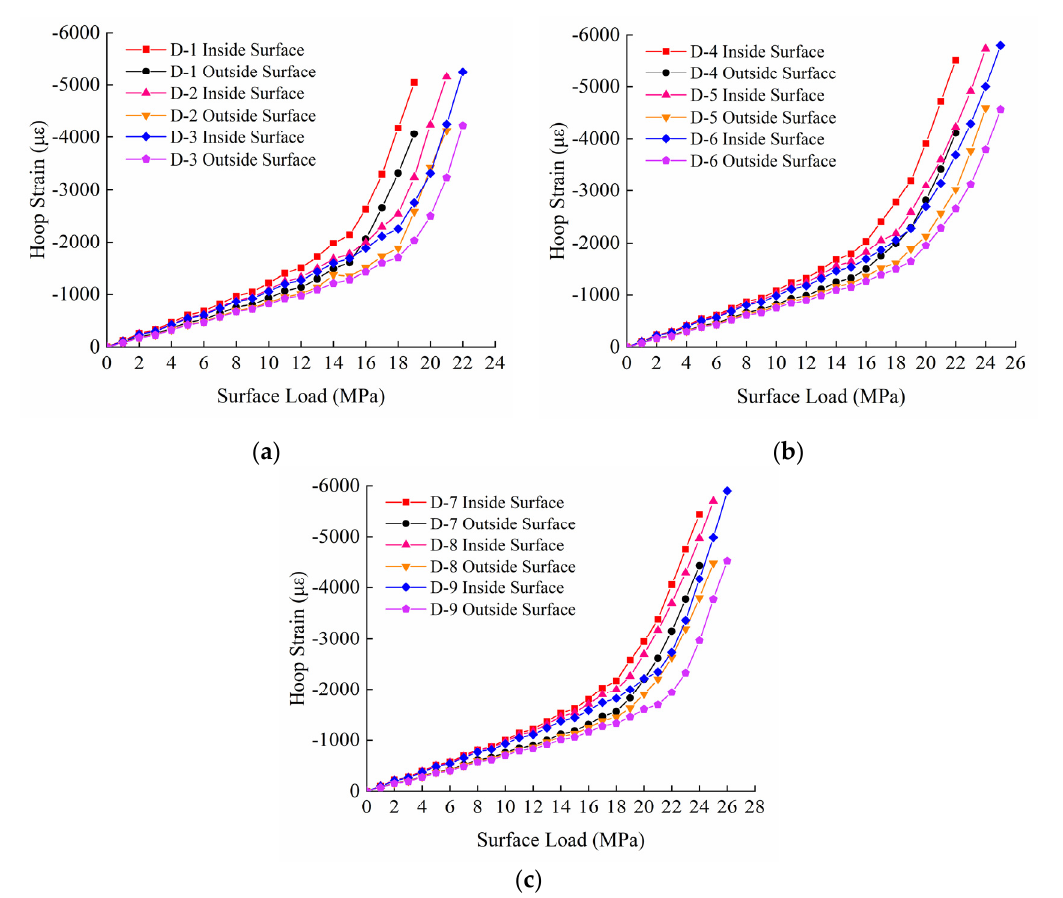
Figure 10. Relationship between hoop strain and surface loads of the shaft lining: ( a ) D-1~3 (shaft thickness 97.6 mm); ( b ) D-4~6 (shaft thickness 104.2 mm); ( c ) D-7~9 (shaft thickness 110.5 mm).